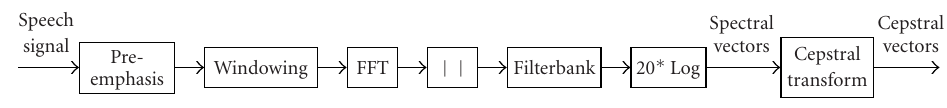
Figure 3: Modular representation of a filterbank-based cepstral